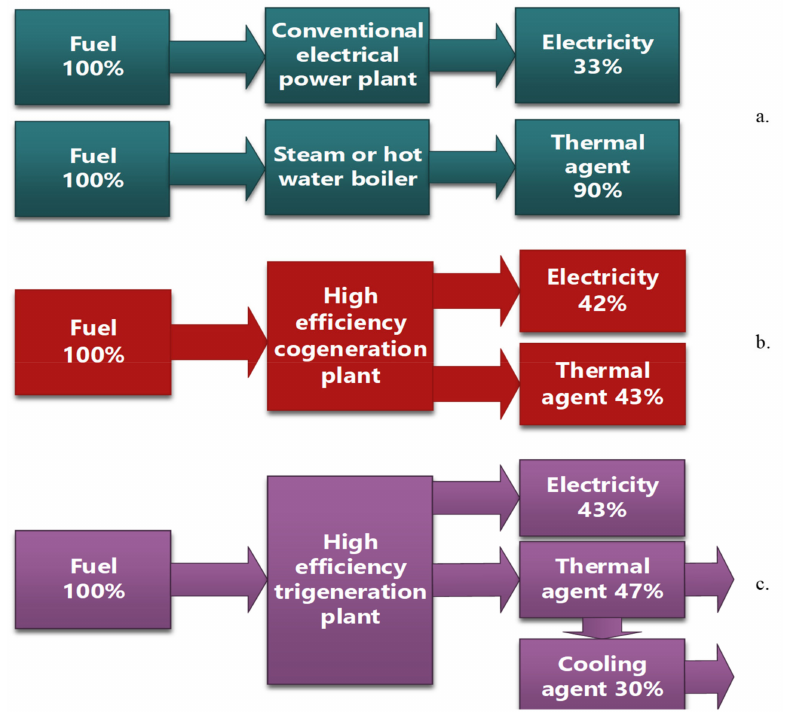
Figure 3. Energy efficiency for different energy production processes. ( a ) Process efficiency 61.50% ((33 + 90)/200 = 0.615); ( b ) process efficiency 85% ((42 + 43)/100 = 0.85); ( c ) process efficiency up to 90% ((43 + 47 (30% − cooling agent))/100 = 0.90).